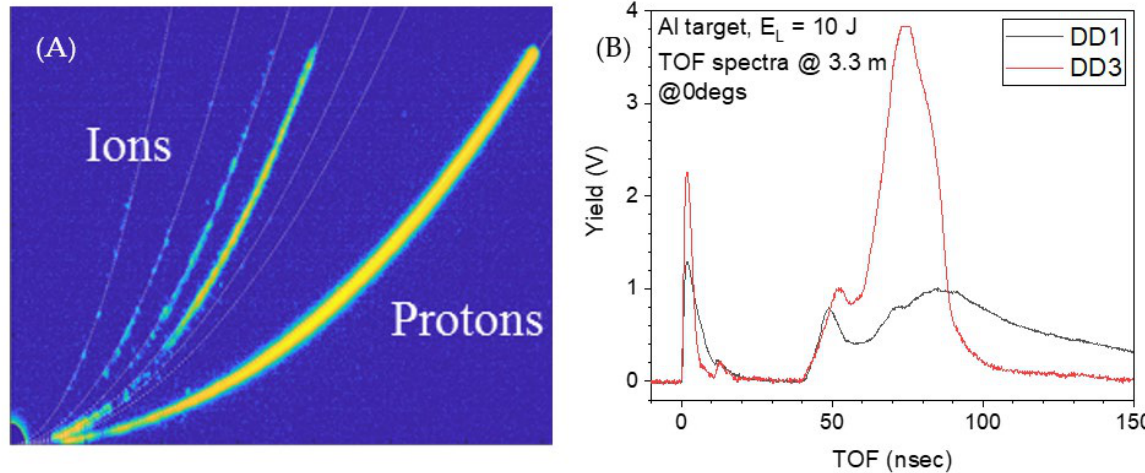
Figure 21. A typical TPS spectrogram ( A ) and TOF spectra ( B ).